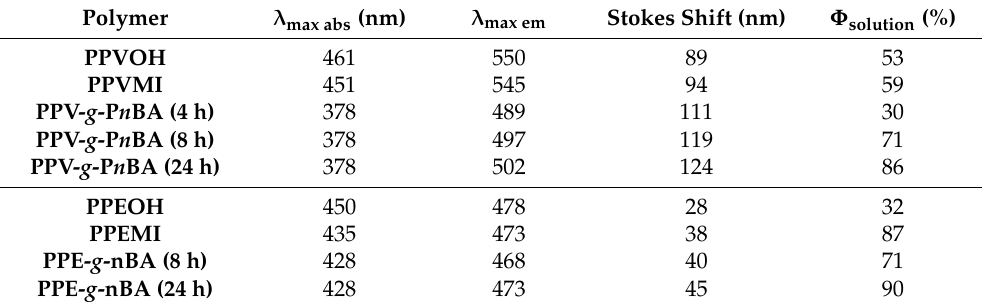
Table 2. Absorption and emission max, stokes shift and quantum yields of PPVs and PPEs grafted with P n